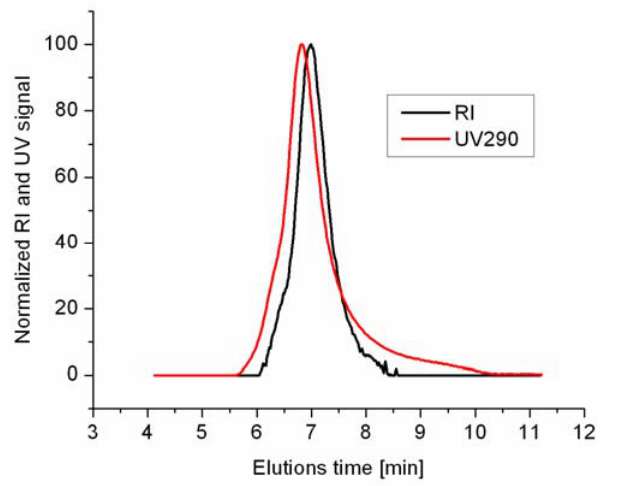
Figure 1. Size exclusion chromatograms of copolymer 5